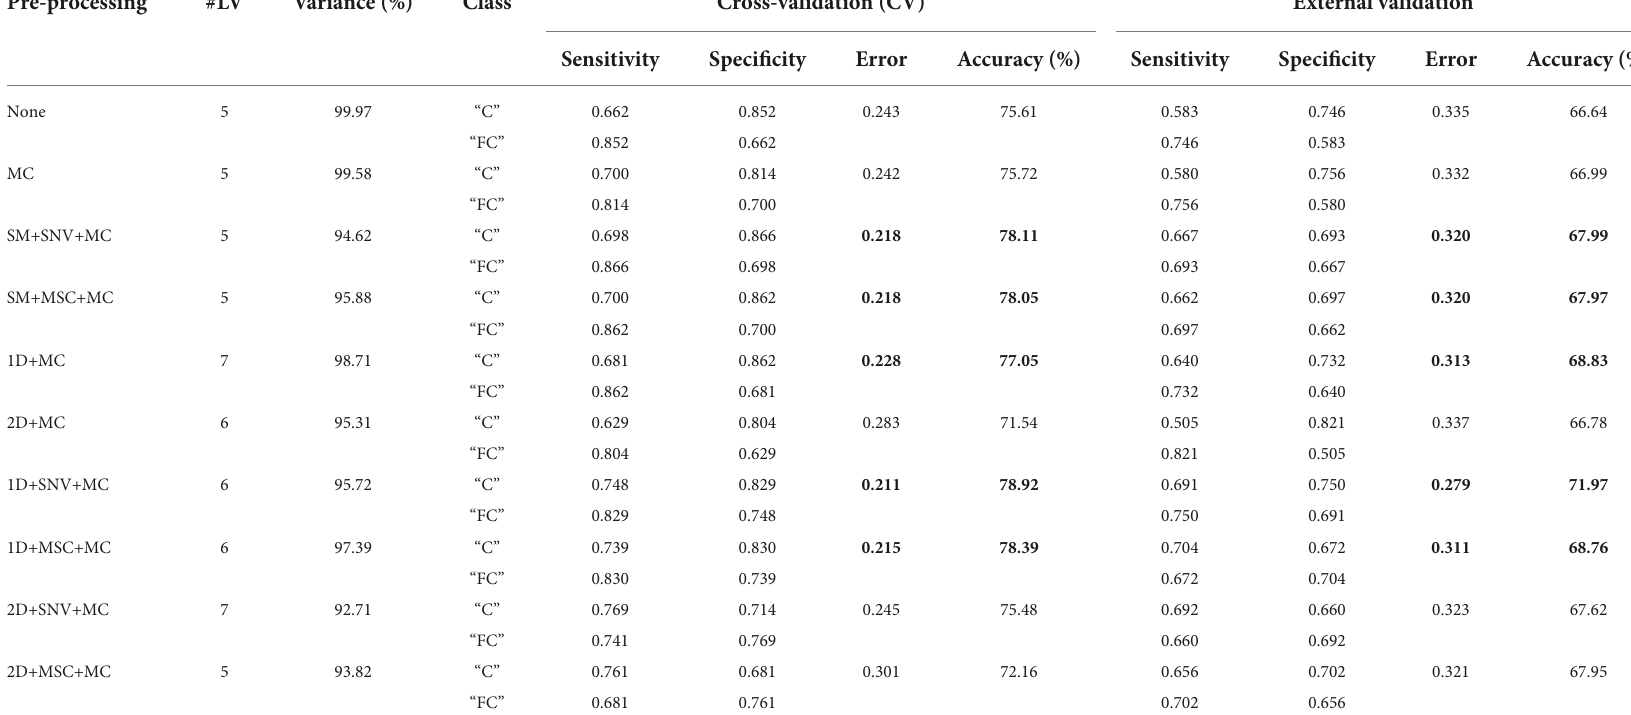
TABLE 5 PLS-DA results of the pixel-wise classification of the CV and external validation datasets using different pre-processing combinations.